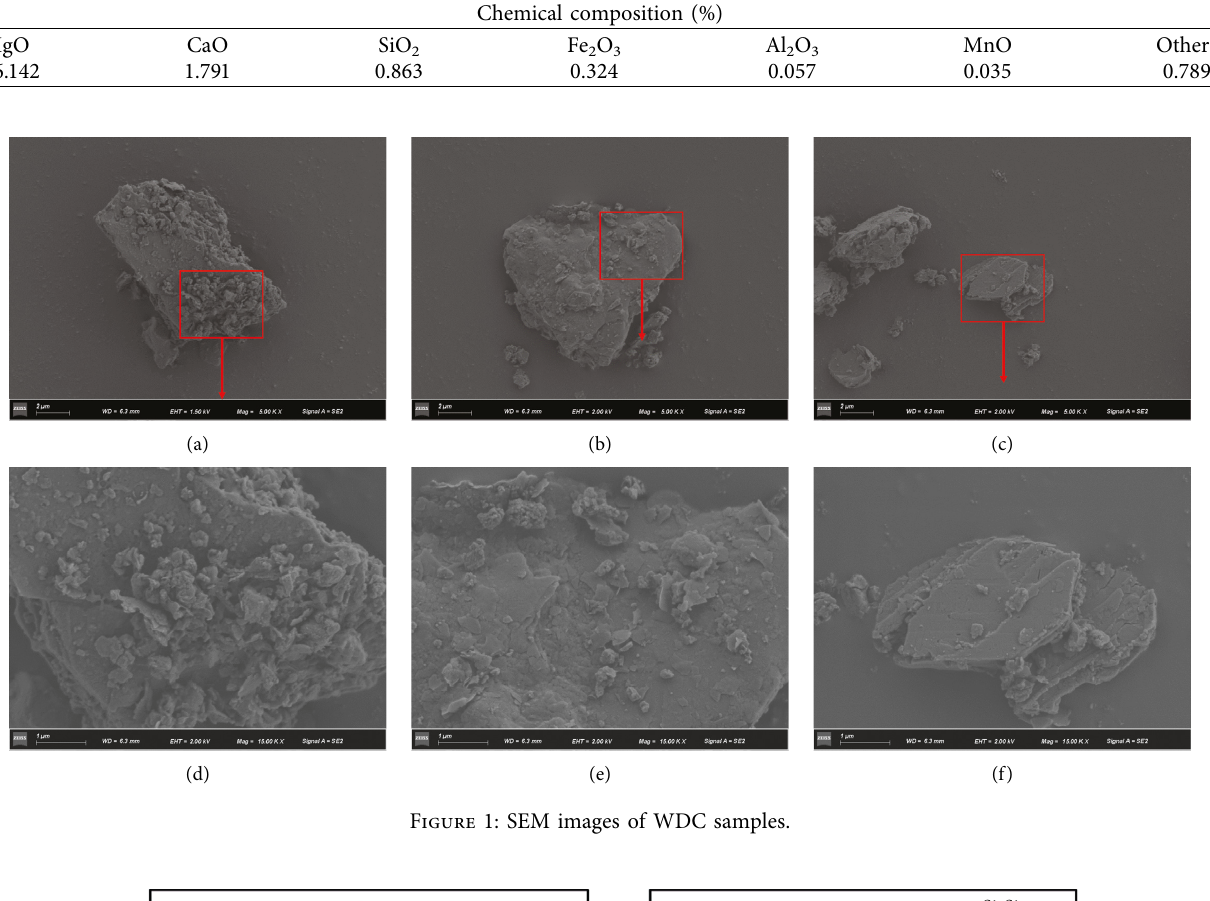
Table 1: Chemical composition of RMC.